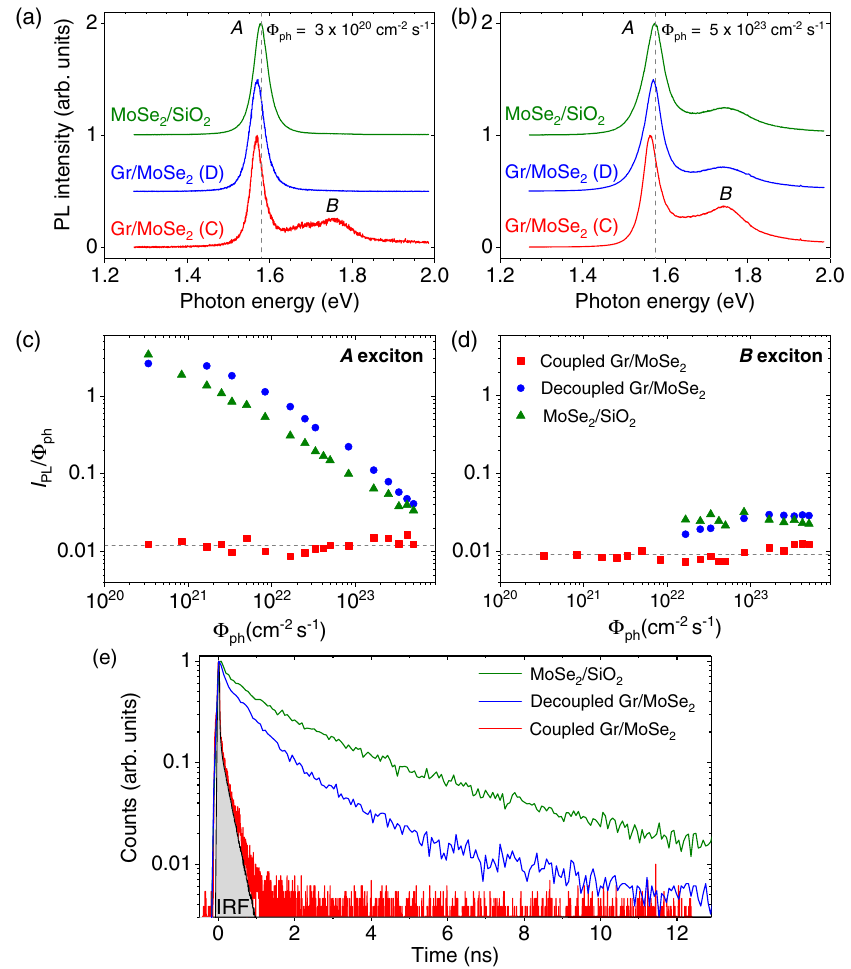
FIG. 2. Normalized photoluminescence spectra of MoSe 2 recorded in the cw regime at a laser photon energy of 2.33 eV, with an ¼ 3 × 10 20 cm − 2 s − 1 and (b) Φ ¼ 5 × 10 23 cm − 2 s − 1 for MoSe = SiO incident photon flux (a) Φ 2 2 , and decoupled (D) and coupled ph ph (C) Gr = MoSe 2 . The A and B excitons are labeled, and the position of the A exciton in MoSe 2 = SiO 2 is indicated by a gray vertical dashed line. (b) Integrated photoluminescence intensity of the (c) A and (d) B exciton normalized by Φ as a function of Φ . The gray dashed ph ph line is a guide to the eye. The error bars are smaller than the symbol size. (e) Photoluminescence decays recorded using a pulsed laser at 1.96 eV with a fluence of 2 . 2 × 10 11 cm − 2 per pulse. The gray area corresponds to the instrument response function (IRF). All measurements were performed in ambient